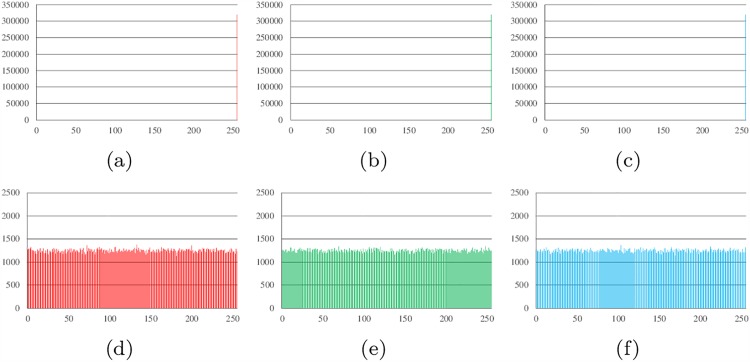
Histogram analysis results of white.(a) Histogram of red channel of white; (b) Histogram of green channel of white; (c) Histogram of blue channel of white; (d) Histogram of red channel of cipher; (e)Histogram of green channel of cipher (f)Histogram of blue channel of cipher.